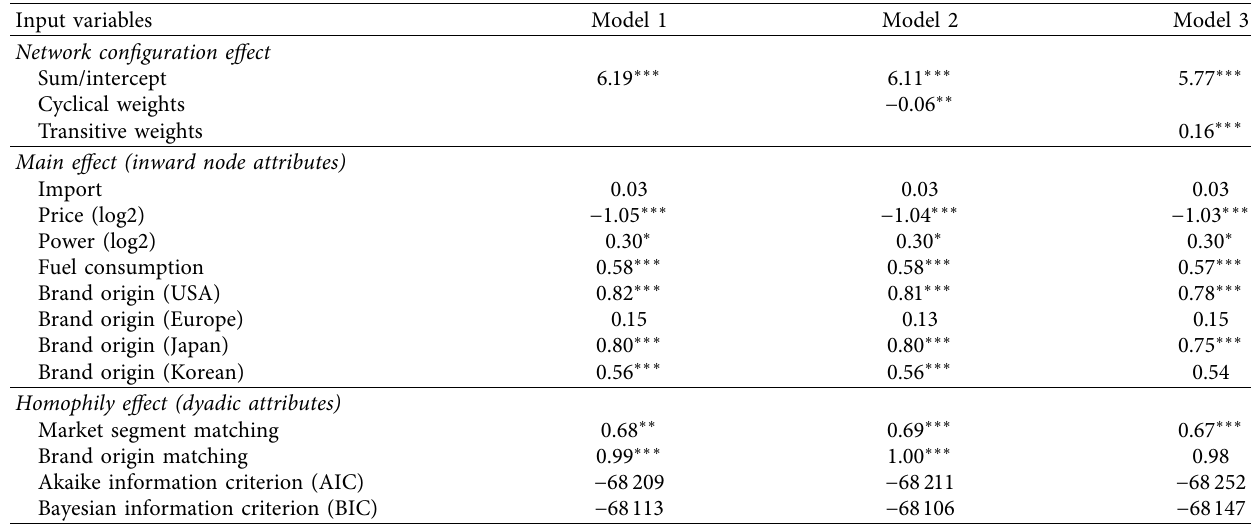
Figure 6: A force-directed graph visualization of the 2013 choice network for crossover SUVs. We observe that most crossover SUVs compete with Sedans and SUVs. Table 4: Estimated coefficients of the 2013 choice